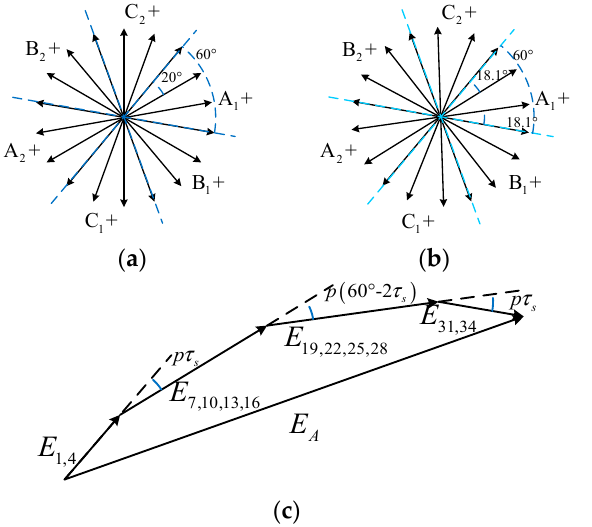
Figure 6. Star of slots and resultant phasors of target machines: ( a ) regular machine with τ t = 20°; ( b ) proposed machine with τ t = 18.1°; ( c ) resultant phasors of back-EMF.